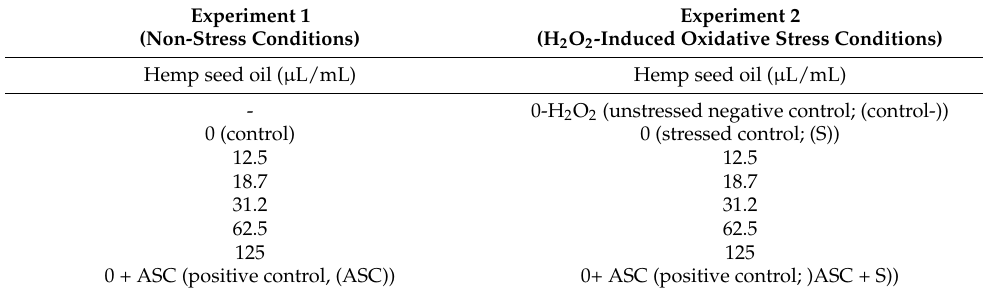
Table 1. The experimental treatments evaluated in the study. Ascorbic acid (ASC) was added to the feeding medium of the D. melanogaster larvae at the concentration of 20 mM. H 2 O 2 was added to the feeding medium in sublethal concentrations